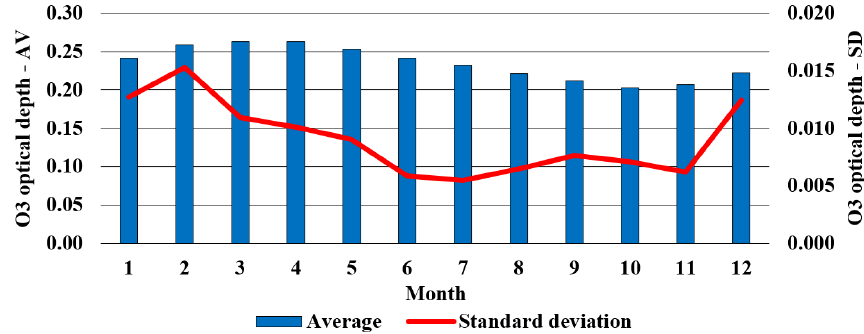
Figure 12. Average monthly characteristics of the total ozone optical depth for the wavelength of 320nm, 1994–2016.